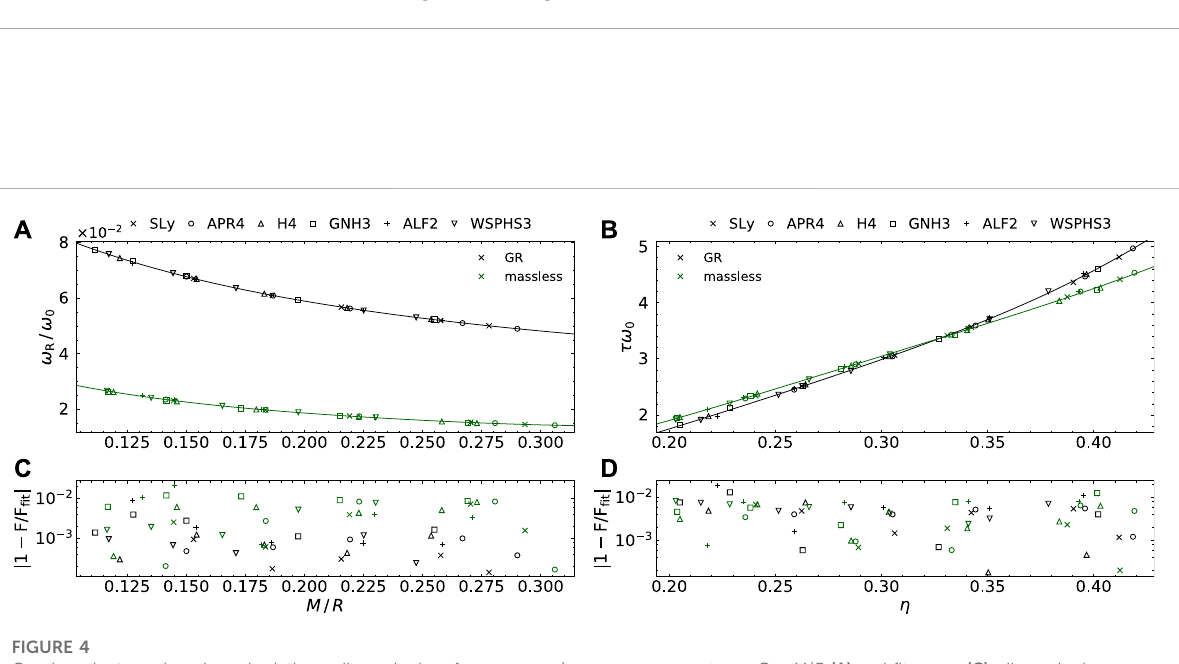
FIGURE 3 Quadrupole ϕ -mode universal relations: dimensionless inverse damping time M /( c τ ) versus compactness C = M / R (A) and fi t errors (C) ; dimensionless inverse damping time R /( c τ ) versus generalized compactness η (B) and fi t errors (D) . The symbols indicate the respective equation of state. The massless scalar – tensor case is shown in green, and the general relativistic case is shown in black.